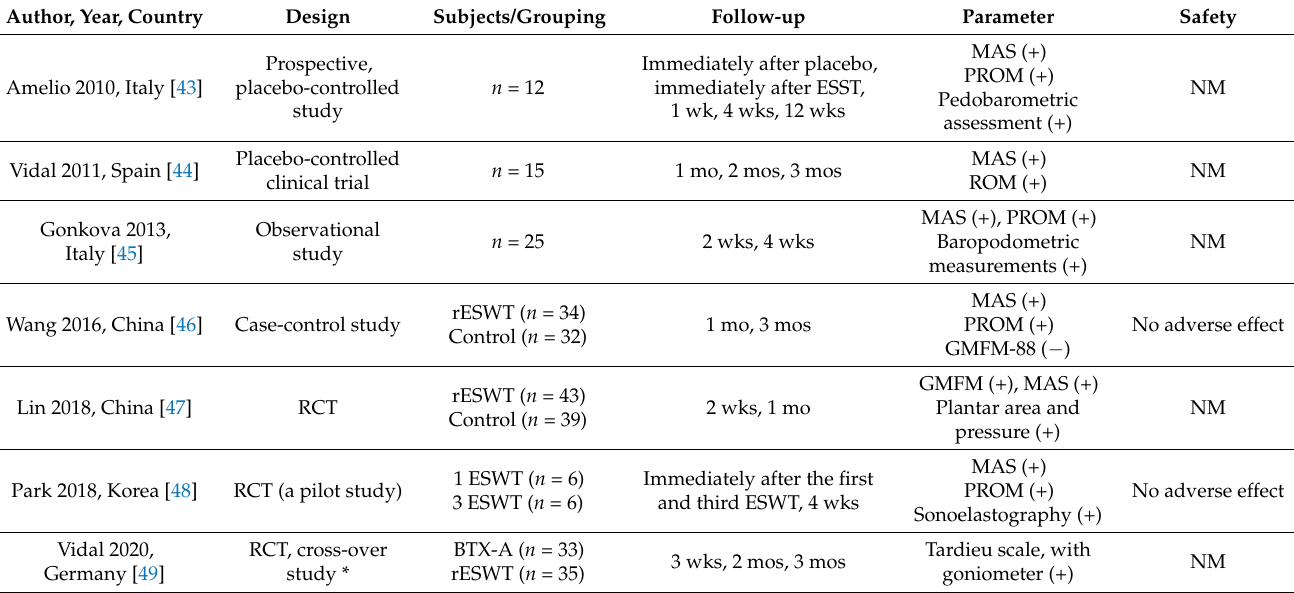
Table 5. Cerebral palsy studies: design and outcome